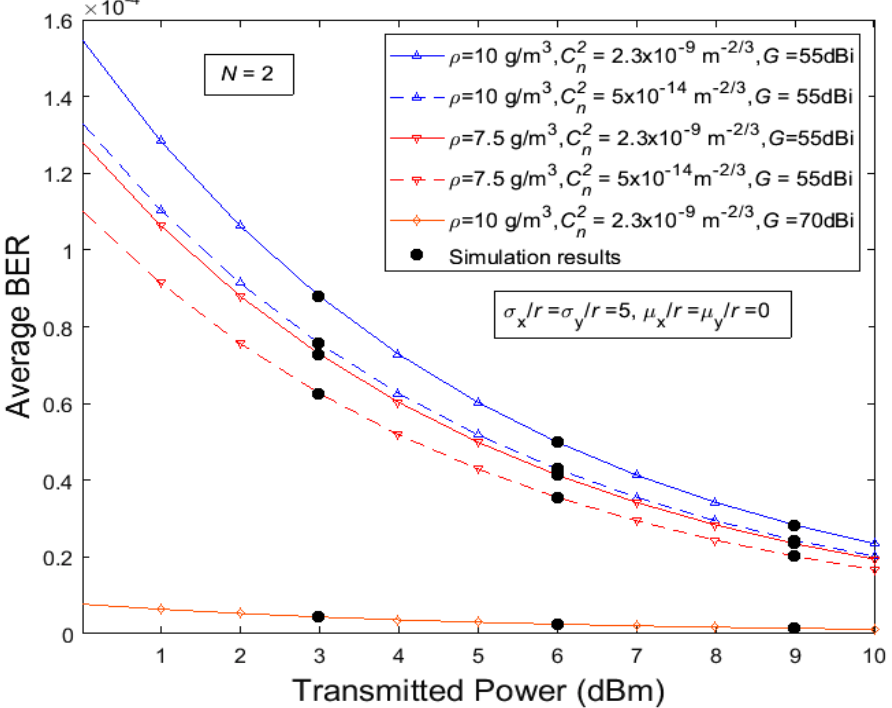
Figure 3. ABER vs. transmitted power for a dual-hop THz link configuration with different antenna gains, weak-to-strong turbulence, moderate-to-high water vapor concentrations and weak ZB pointing errors.